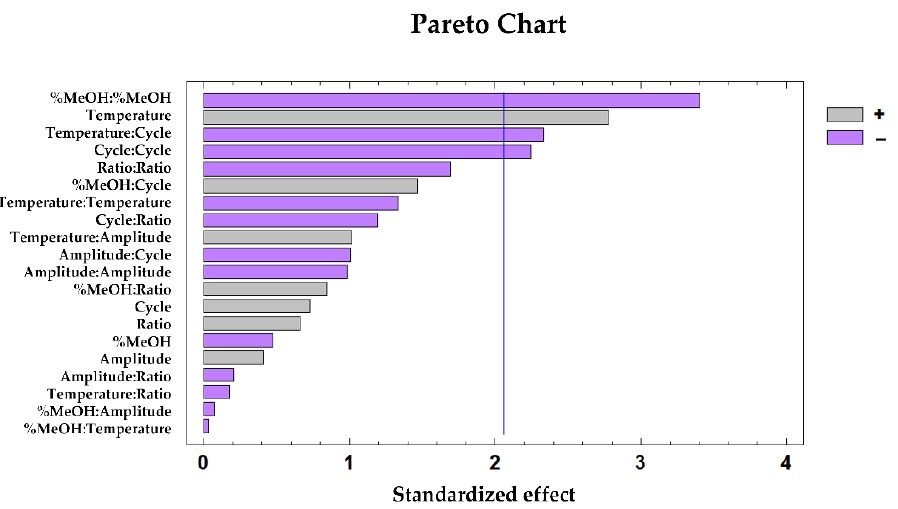
Figure 5. Pareto chart generated based on the BBD–RSM design of the antioxidant capacity of the mushroom samples according to the ABTS method.